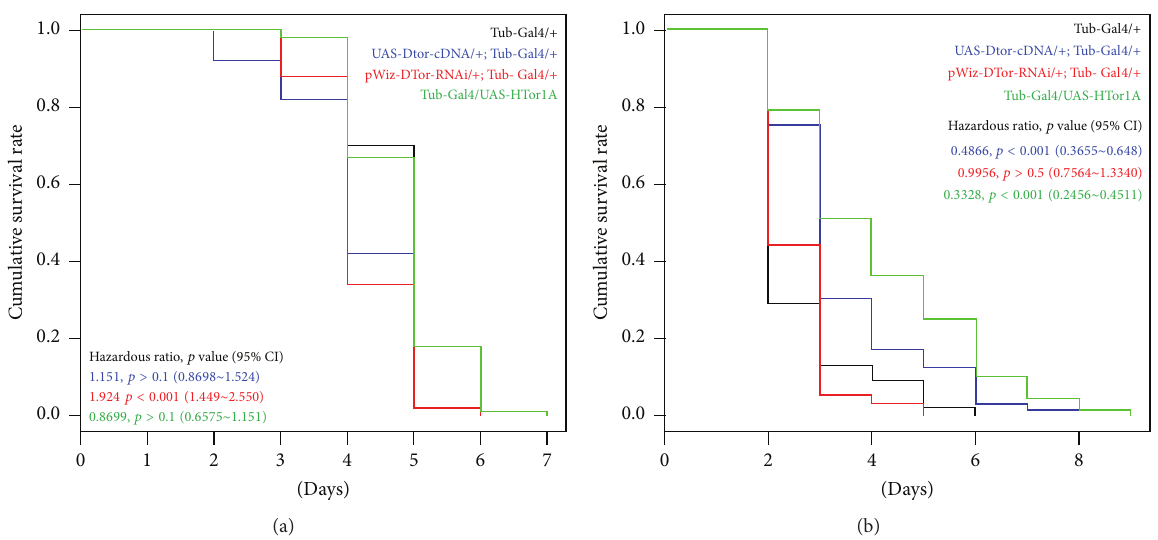
Figure 5: Kaplan-Meier survival analysis of chemically induced oxidative stress with different expression levels of DTor in Drosophila . (a) When flies were treated with H 2 O 2 , only DTor-RNAi expressing flies showed significantly increased HR. (b) When flies were treated with paraquat, DTor-cDNA, or HTor1A-cDNA-expressing flies showed significantly reduced